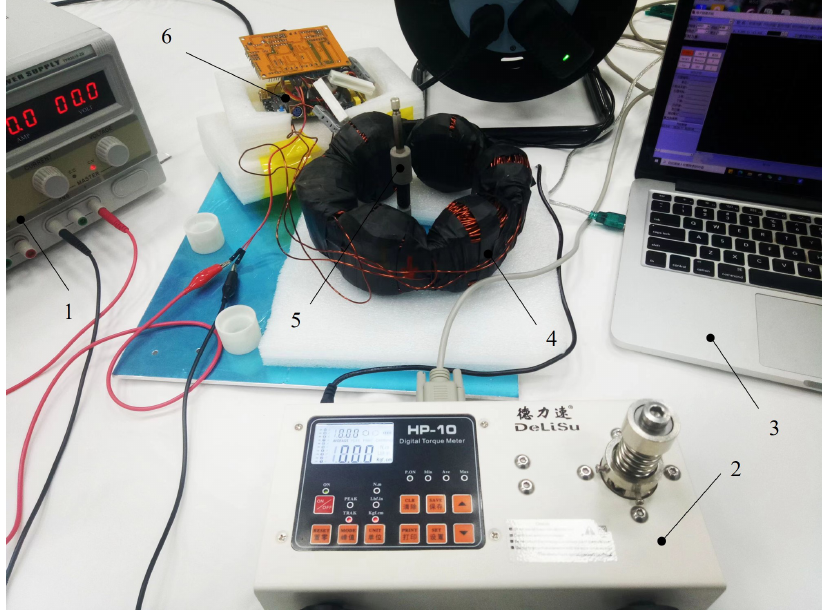
Figure 10. Experiment setup to test permanent magnet driving torque. 1—power supply, 2—torque measurement system, 3—computer, 4—stator core, 5—permanent magnet, 6—microcontroller unit. The maximum and minimum values of experimental driving torque data are around 9.8 Nmm, and 4.9 Nmm, respectively, and its average value is about 6 Nmm, as shown in Figure 11. The reasons that cause differences in both outcomes may be the frictional force in the permanent magnet shaft, the copper winding is winded manually, the permanent magnet is not in the center position, and the torque measuring system is handheld. The driving torque can be measured more accurately if the problem stated is completely